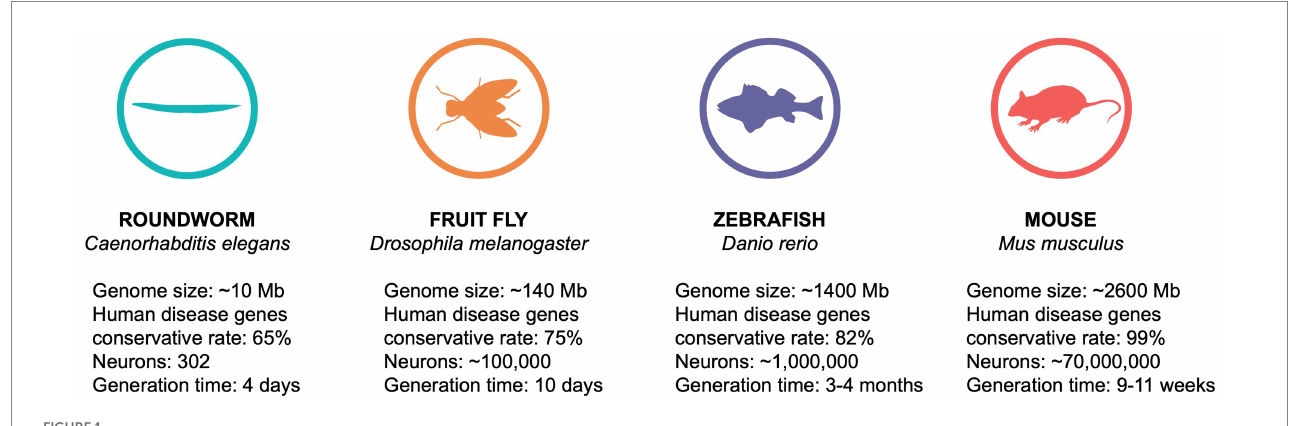
FIGURE 1 Comparison of animal models used in epilepsy